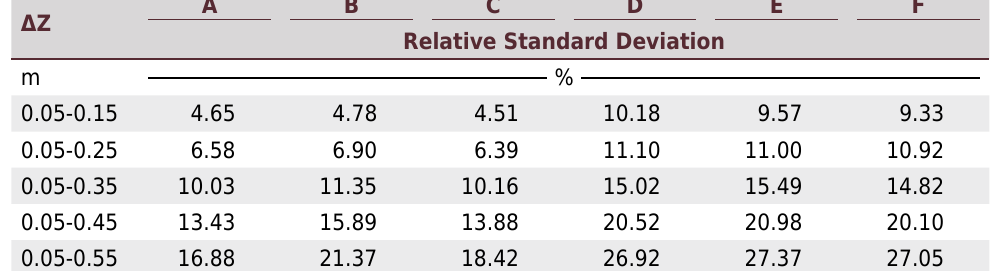
Table 3. Percentage of error calculated the apparent diffusivity experiments April and August 2013 A B C ΔZ